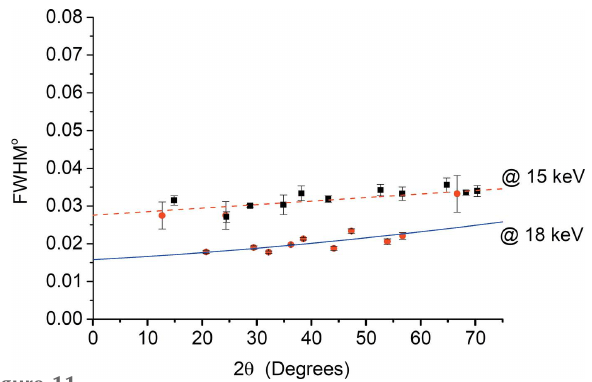
Figure 11 Instrumental angular resolution function measured by Si (NIST 640f) at 15 and 18